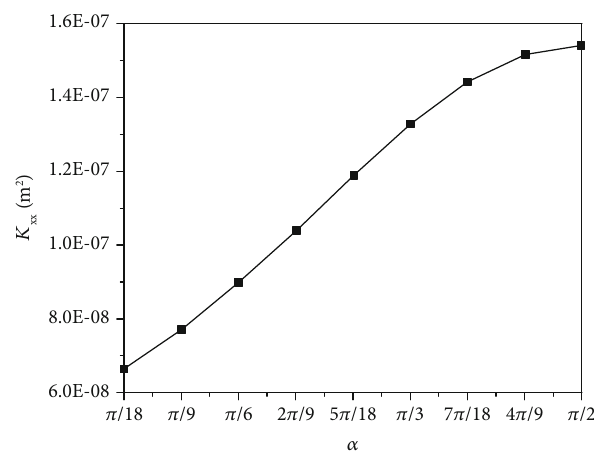
Figure 12: The relationship between β and K and α ( D = 1 : 4 , D = 1 : 1 , xx f T θ = π /6 , and α = π /2 ).